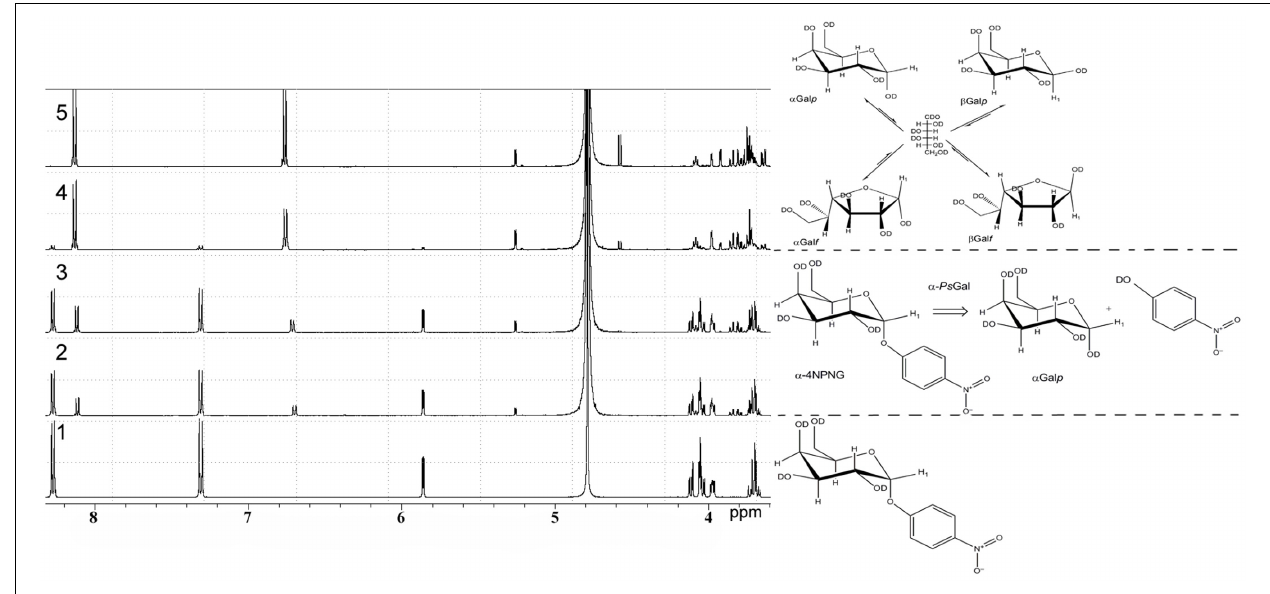
τ = 0min (spectrum 1), at τ = 3min (spectrum 2); at τ = 6min (spectrum 3); at τ = 24min (spectrum 4); at τ = 60min (spectrum 5) after initiation of the